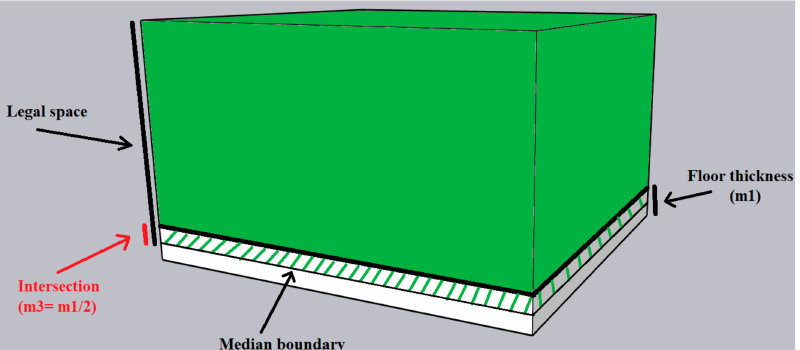
Figure 4. Using (thickness of intersection between the floor and legal space) for identifying a Median